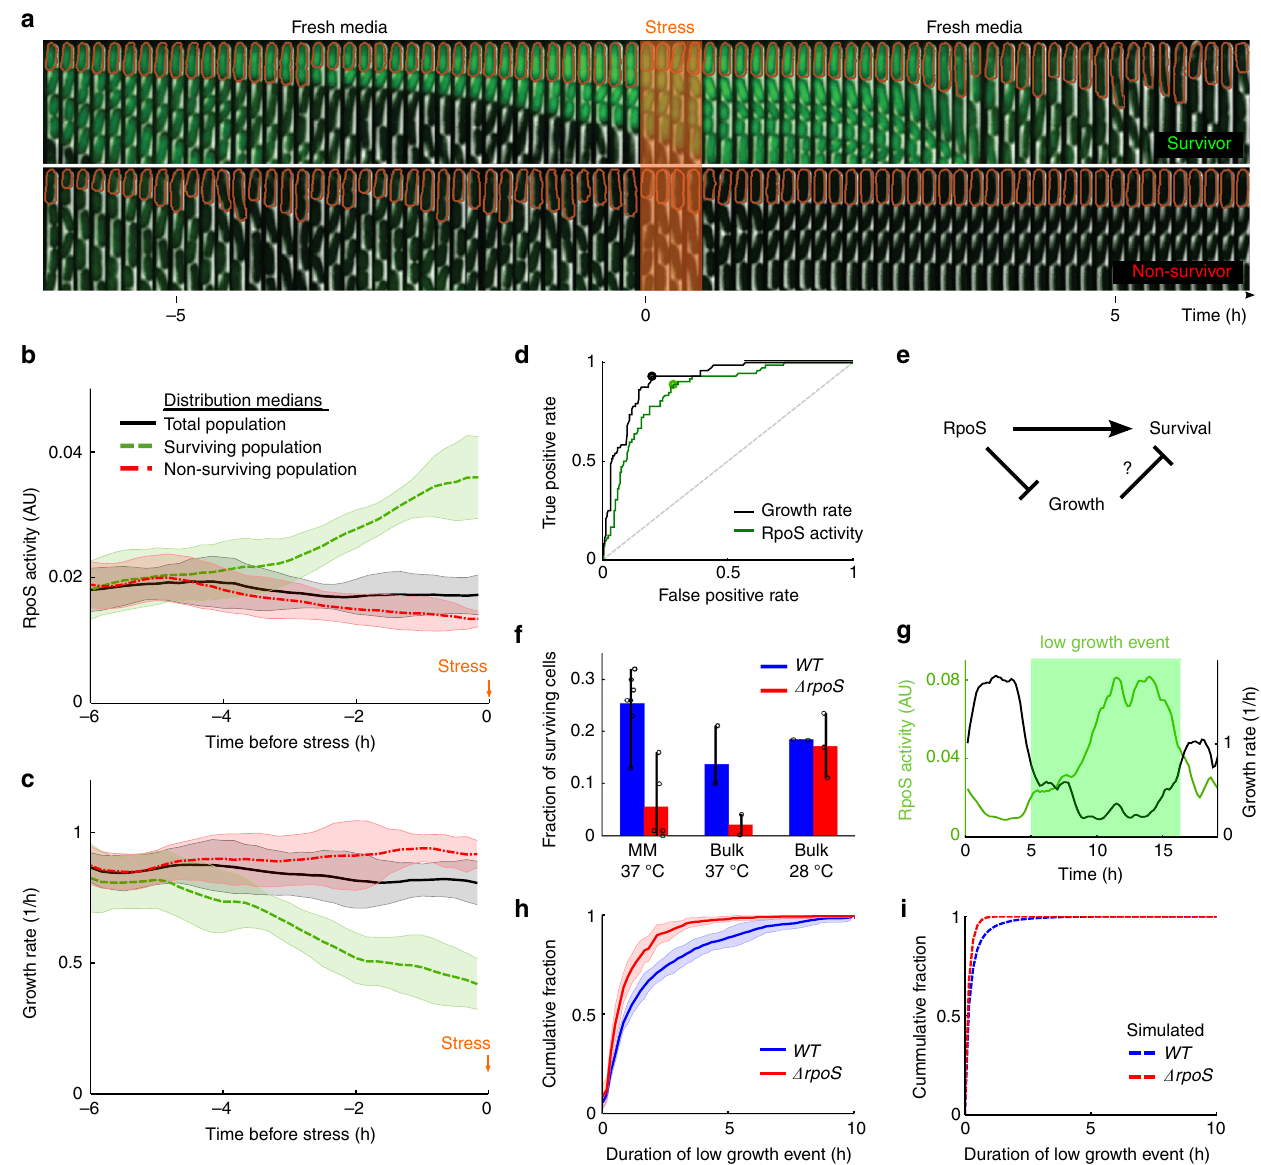
Fig. 4 RpoS enables survival of stress by prolonging duration of slow growing state. a Schematic of the stress assay and sample montages of surviving (top) and non-surviving (bottom) mother cell (outlined in orange); 1 frame/10 min; phase contrast and fl uorescence channel ranges identical for both montages and chosen for display. Cells were grown in fresh media, followed by application of H 2 O 2 stress, and fresh media once again. b Median value of RpoS activity distributions for time points prior to stress application ( t = 0), sorted according to survival (line and shaded area are mean ± std dev, 7 technical replicates drawn from 4 biological replicates; 72 surviving cells, 212 non-surviving, 284 total mother cells). c Same as b for growth rate. d Receiver operating characteristic curve for growth rate (black) and RpoS activity (green) from time point preceding stress application. Grey dashed line is true positive rate = false positive rate. Circles represent locations of optimal thresholds (0.71/h for growth rate, 0.020 AU for RpoS activity). Area under the curve (AUC) is 0.91 for growth rate and 0.85 for RpoS activity. e Schematic illustrating alternative mechanisms of stress survival. High RpoS activity could directly allow cells to survive or it might fi rst reduce growth rate, which in turn allows survival. f Fraction of cells surviving stress in the Mother Machine assay (mean ± max/min, WT : 7 tech. reps., represented as circles, drawn from 4 bio. reps., 1,087 cells, Δ rpoS : 5 tech. reps. drawn from 3 bio. reps., 996 cells) and bulk culture assay at two temperatures (mean ± max/min; at least two biological replicates for bulk assays, represented as circles). g Illustration of a low growth event based on the ROC curve optimal threshold (0.71/h) ( d ). h Cumulative distribution of duration of low growth events in WT and Δ rpoS populations (mean ± std dev, WT , 11 tech. reps. drawn from 7 bio. reps., 507 mother cells, 961 events; Δ rpoS , 10 tech. reps. drawn from 6 bio. rep., 274 mother cells, 484 events). i Same as h from simulations (1000 simulations run for 500 h, only the fi nal 250 h were used; WT , 96,996 events and Δ rpoS